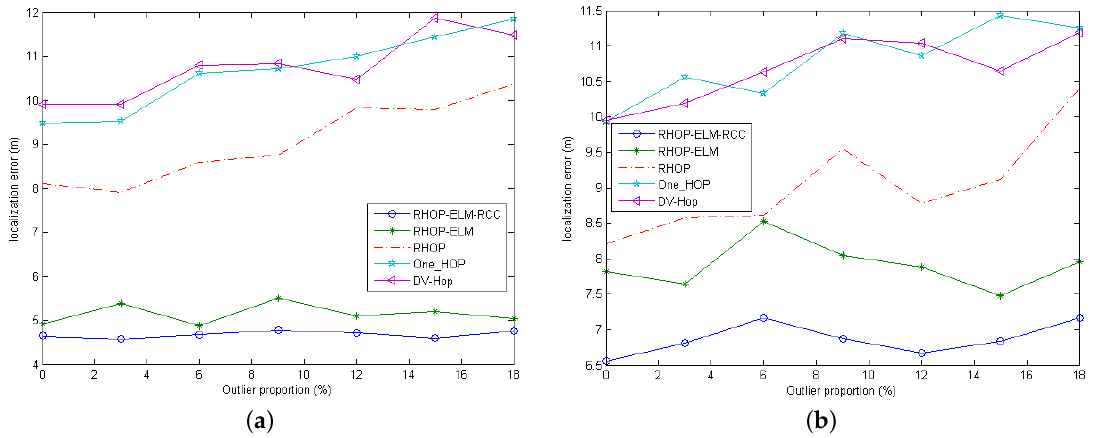
Figure 8. Localization errors against the outliers. ( a ) The case with 50 nodes in the area of 50 m × 50 m; ( b ) The case with 100 nodes in the area of 100 m × 100